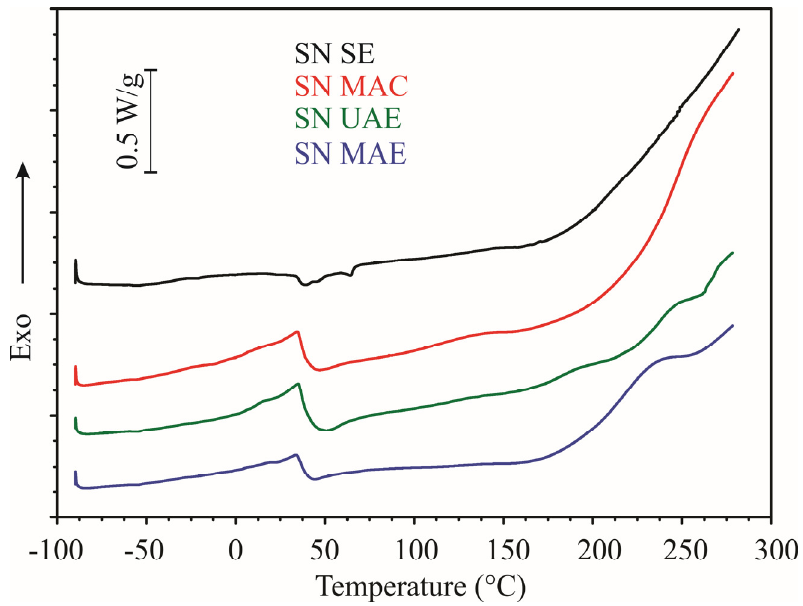
Figure 1. DSC curves of dried nettle extracts. Heating rate 5 °C/min, nitrogen flow 50 mL/min. Thermogravimetric (TG) and differential TG (DTG) curves of dried nettle extracts are